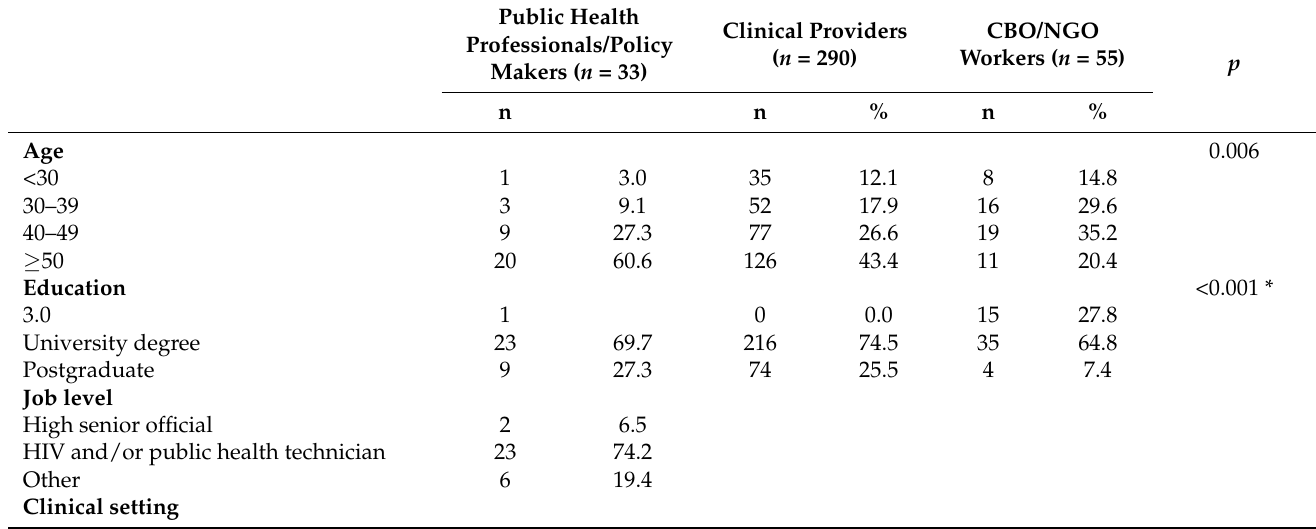
Table 1. General characteristics of participant